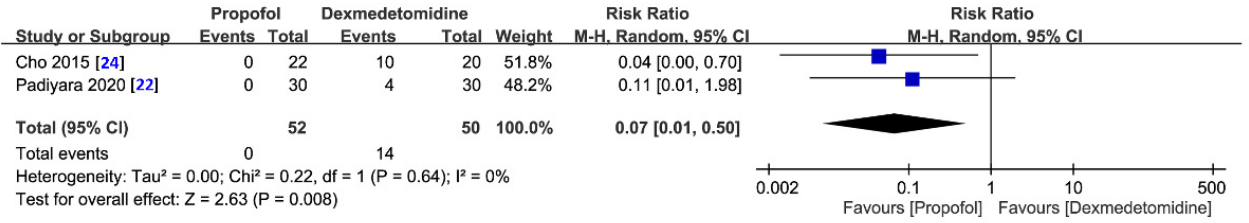
doscopy between propofol and dexmedetomidine groups. CI, confidence interval; M–H,